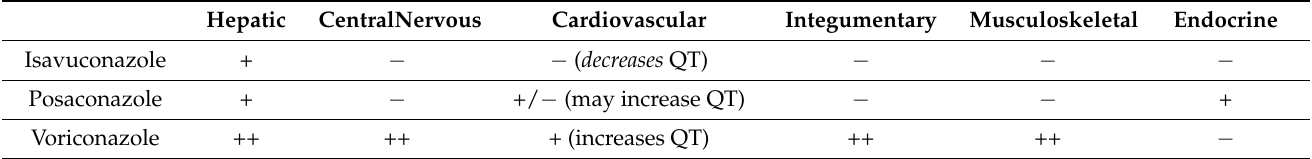
Table 2. Organ system-based adverse reactions potential and magnitude of effect in lung transplant recipients [22–28]. Hepatic CentralNervous Cardiovascular Integumentary Musculoskeletal